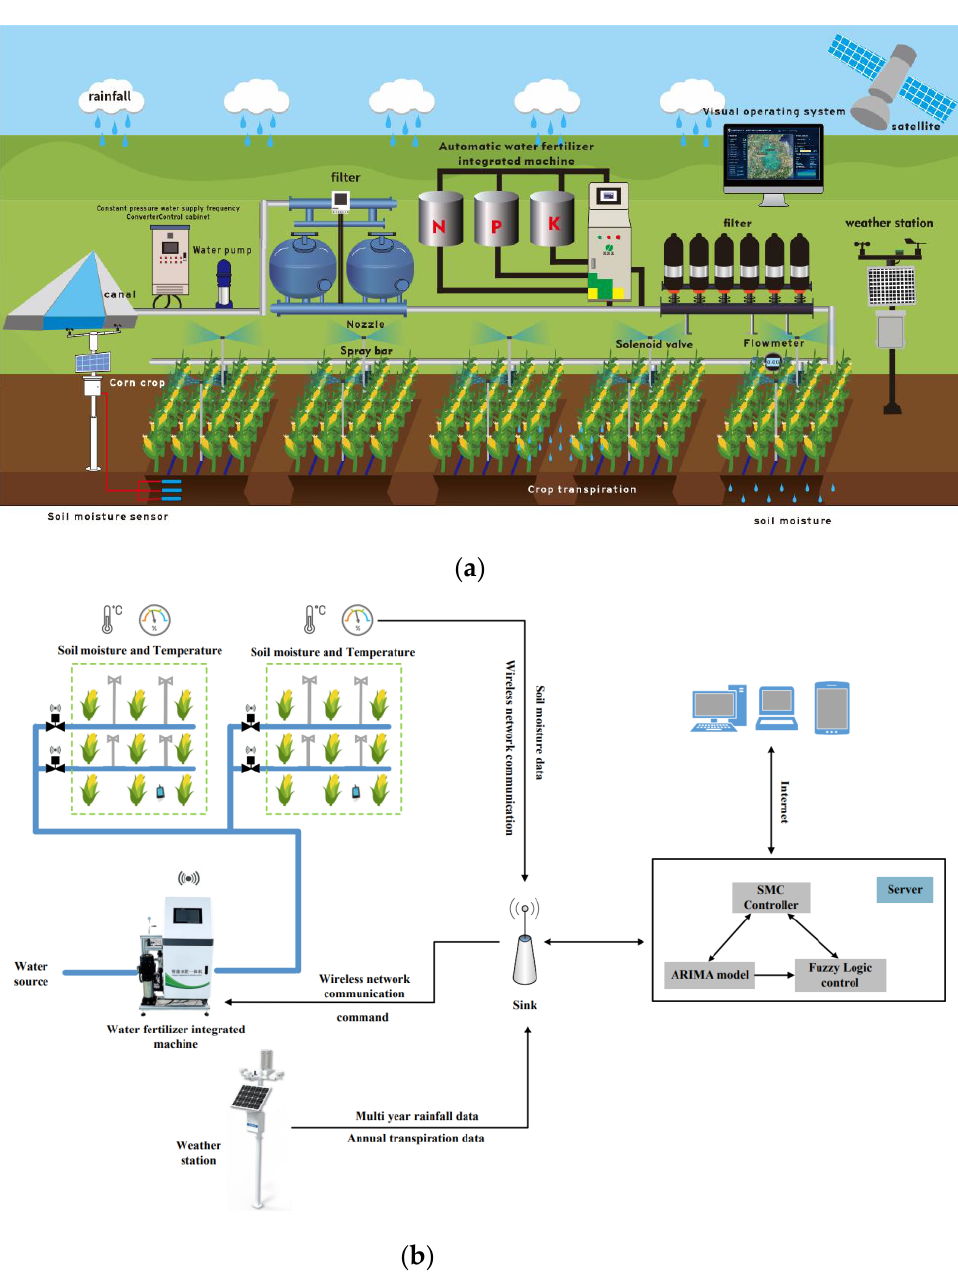
Figure 1. Intelligent irrigation control system diagram: ( a ) irrigation equipment diagram; and ( b ) system schematic.